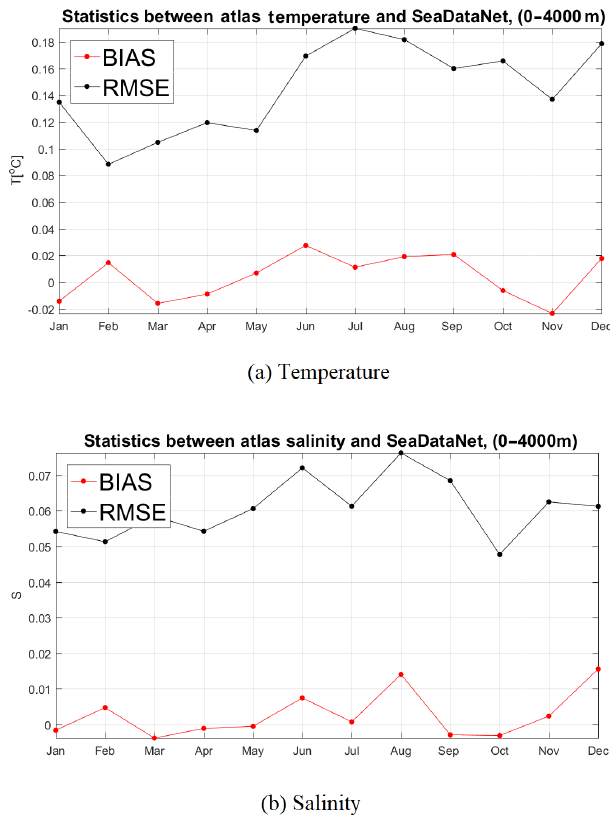
Figure 10. Basin vertical averages of BIAS and RMSE between the atlas and SeaDataNet monthly temperature (a) , and monthly salin- ity (b)